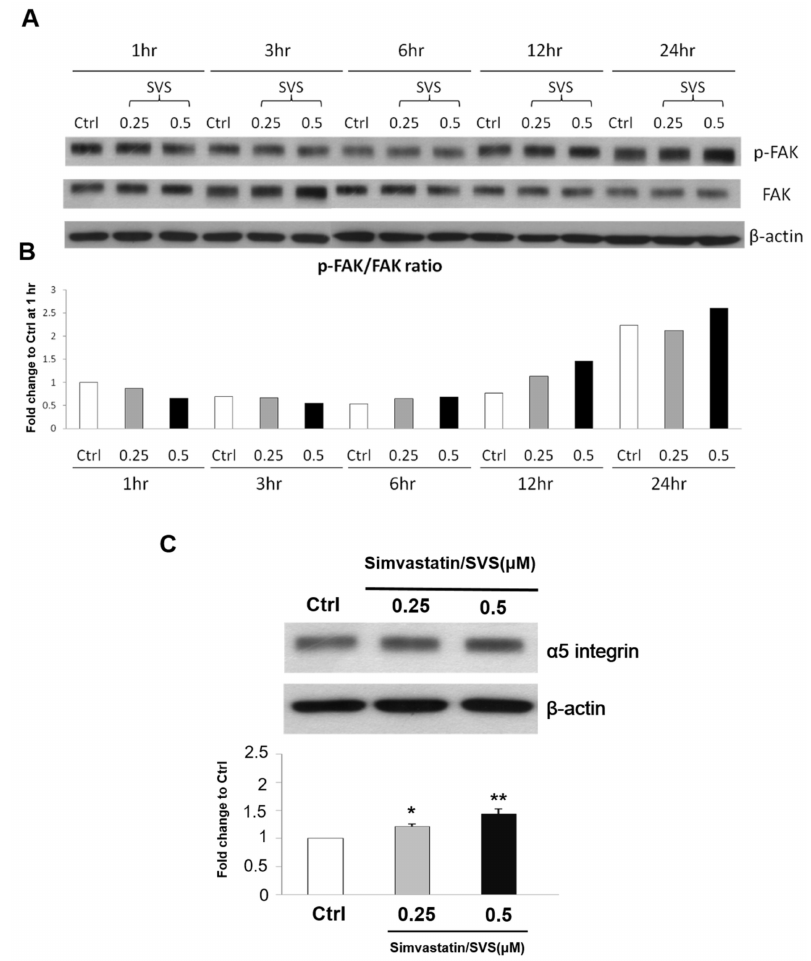
Figure 4. SVS increases the protein expression level of the phosphorylated focal adhesion kinase/ focal adhesion kinase (p-FAK/FAK) ratio and α 5 integrin in D1 cells. D1 cells (passage 8) were treated with 0 (Ctrl), 0.25, and 0.5 µ M SVS for 1–24 h. ( A ) The protein expression levels of p-FAK and FAK in D1